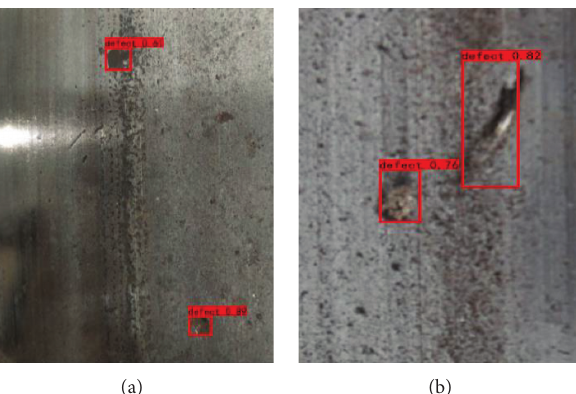
Figure 9: A visual example of WT-NET’s test results. The red box is the bounding box indicating its location, and the black word is its category score.